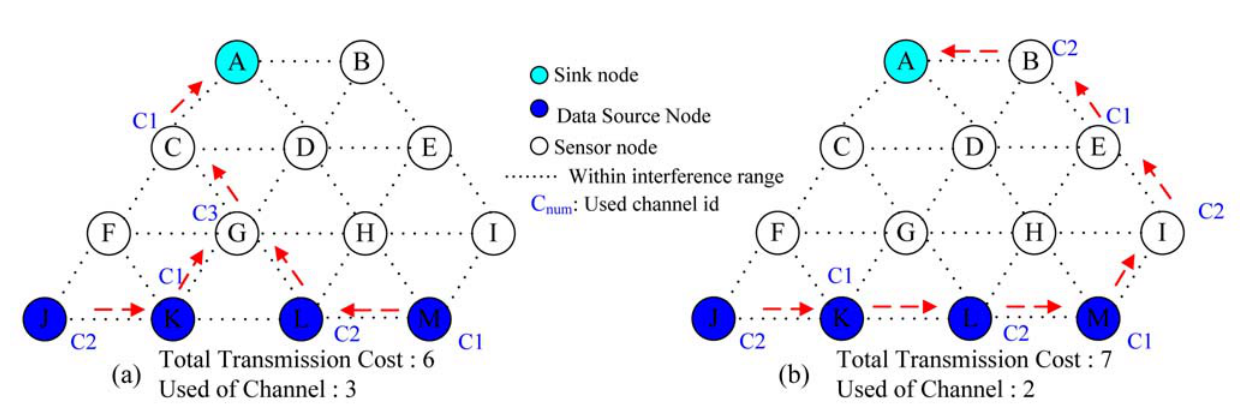
Figure 6. Illustrative example for LGR-Primal